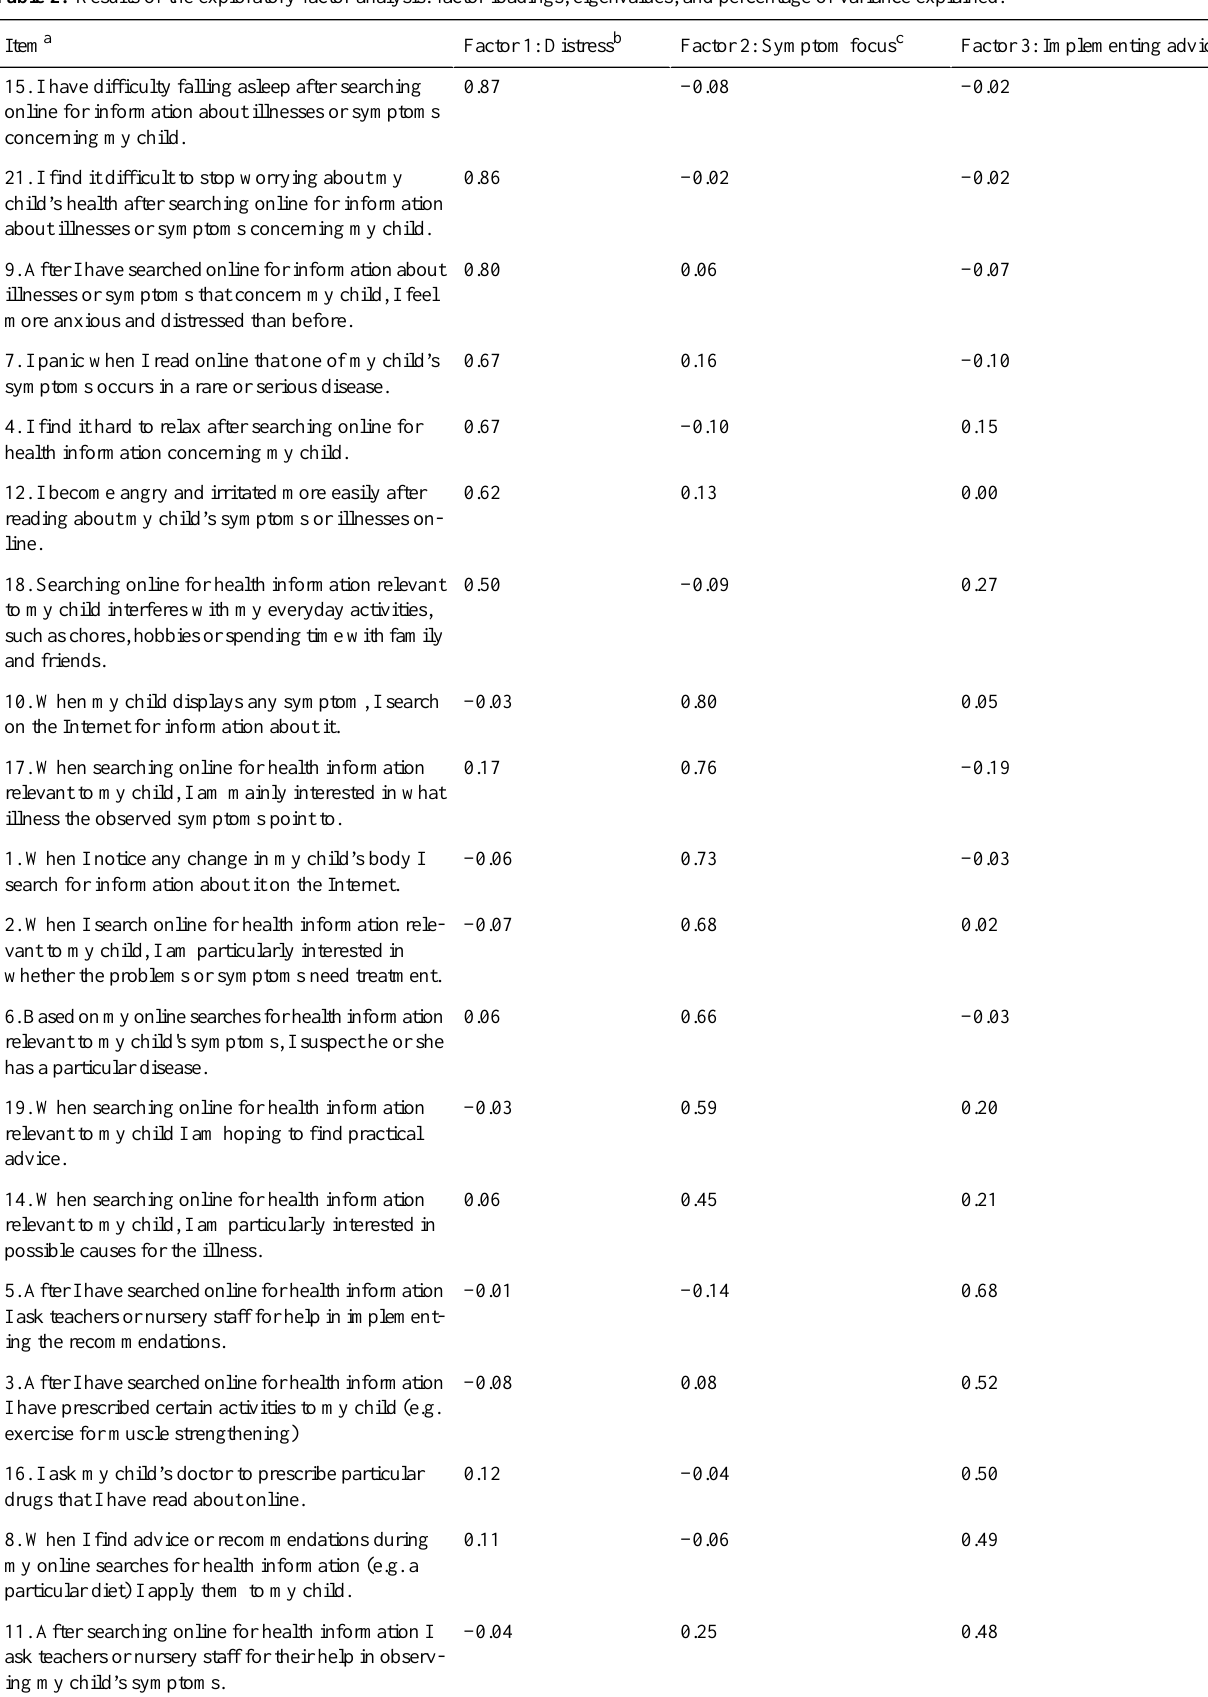
Table 2. Results of the exploratory factor analysis: factor loadings, eigenvalues, and percentage of variance explained.